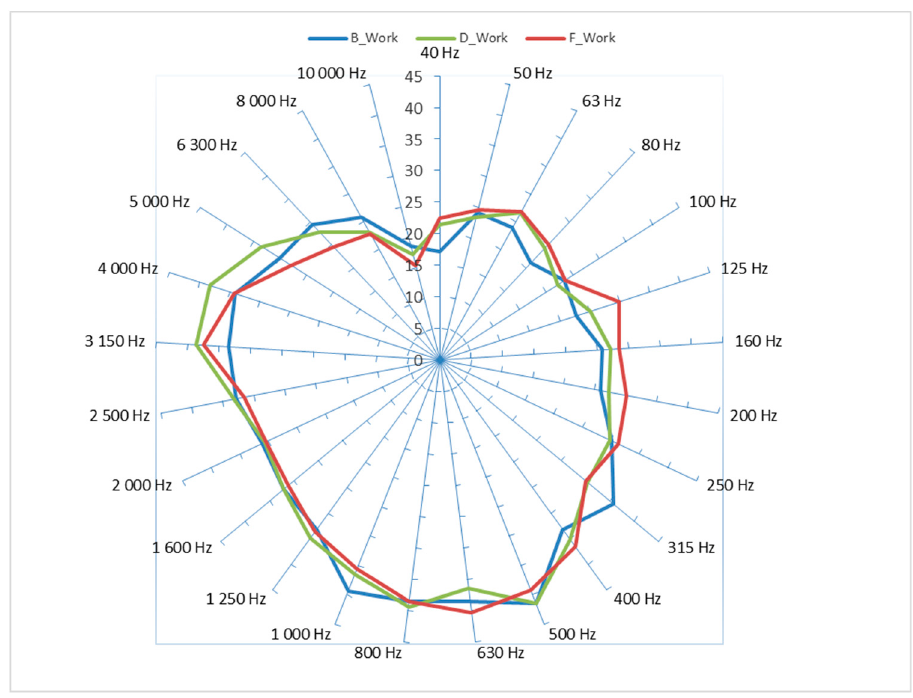
Figure 10. Values of noise emissions measured in residential areas during operation (Work).